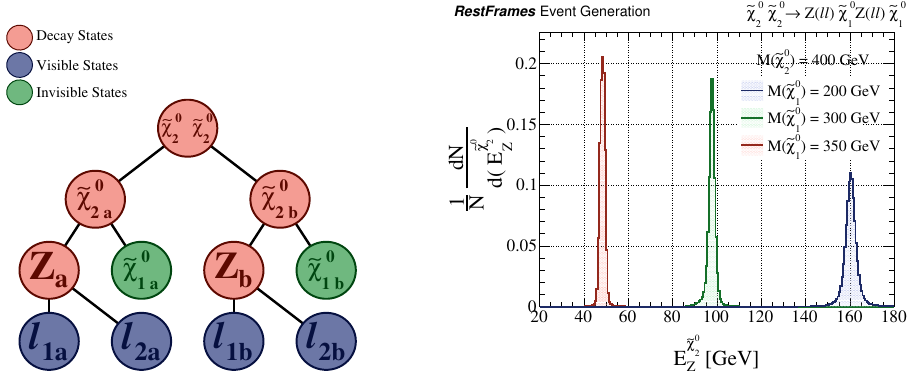
Figure 5 . (Left) Decay topology for pair-production of long-lived neutralinos (~ (cid:31) 0 to a Z boson and LSP (~ (cid:31) 0 ). (Right) Distribution of the energy of the Z evaluated in the LLP rest 1 frame for di(cid:11)erent LSP masses, assuming an LLP mass of 400